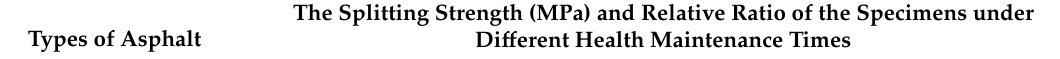
Table 9. Influence of emulsified asphalt on strength development of cold recycled